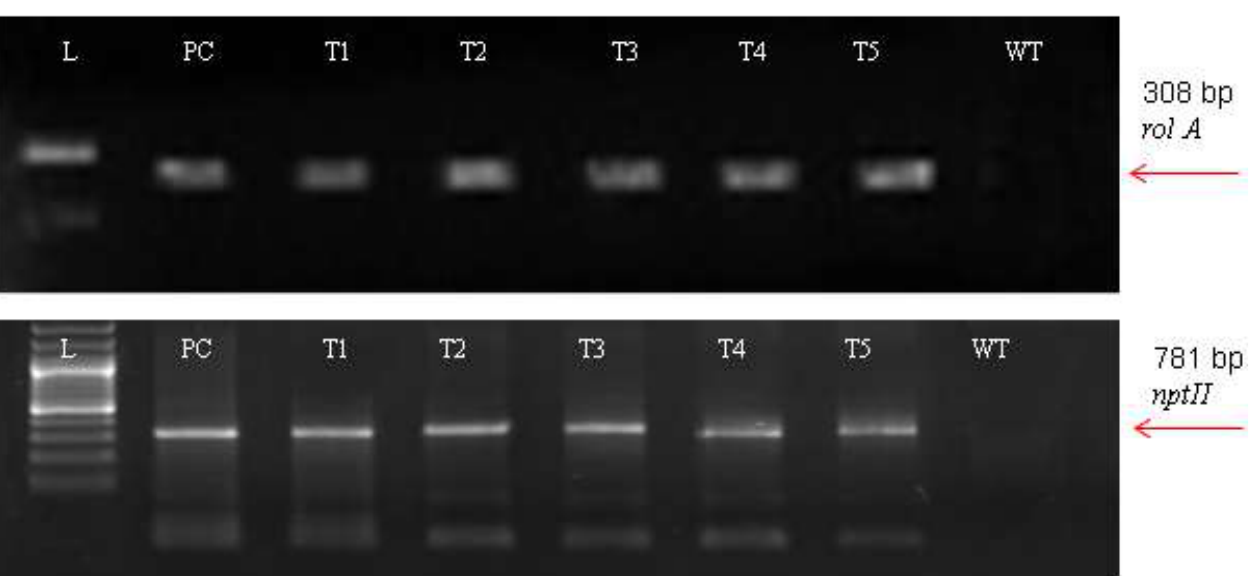
Figure 2. PCR result of transgenic Artemisia carvifolia harbouring rol A genes showing 308 bp for rol A and 781 bp for the nptII gene.